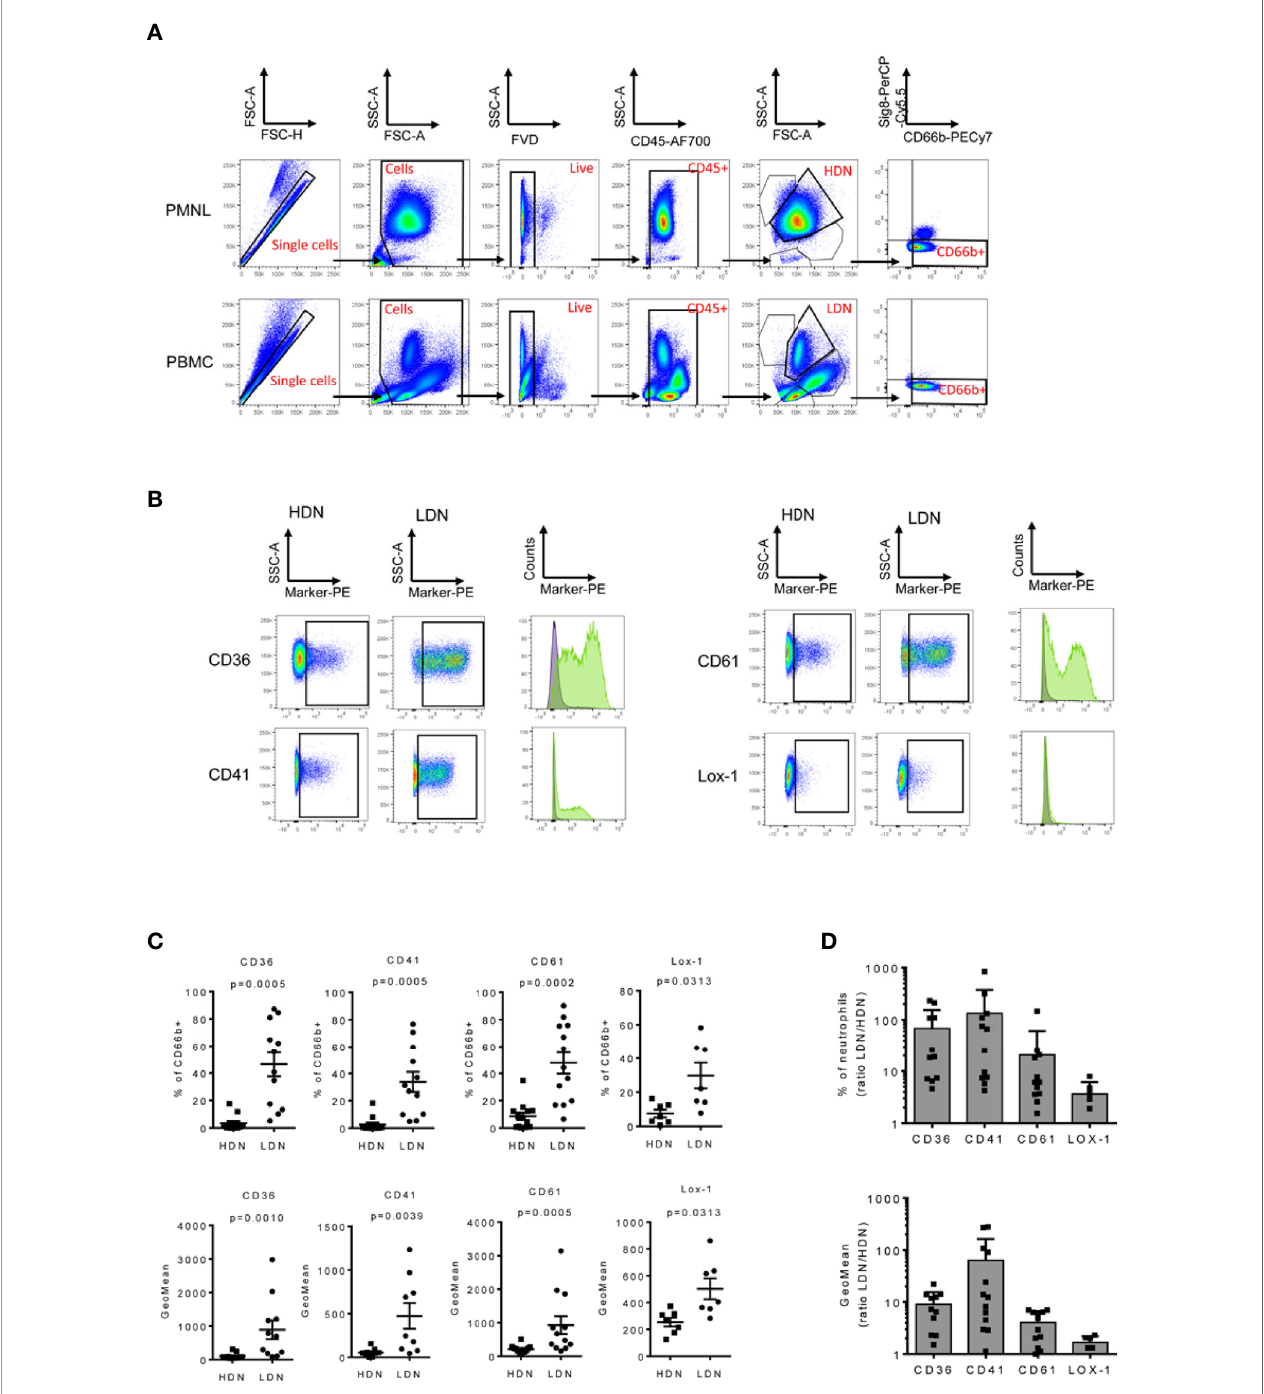
FIGURE 4 | LDNs overexpress CD36, CD41, CD61 and Lox1. PMBCs and PMNLs were isolated from 13 NSCLC patients and stained to validate the surface marker expression by fl ow cytometry. (A) Representative fl ow cytometry dot plots demonstrating the gating strategy. Initial gate is to eliminate doublets from the analysis followed by gating on total cells, live (FVD) and CD45 + cells. HDNs and LDNs were gated base on its forward and side scatter properties. Neutrophils were identi fi ed as CD66b + Siglec8 - cells (B) Representative dot plots and histograms showing an increased expression of CD36 + , CD41 + , CD61 + and Lox1 + in the LDN fraction of cancer patients. (C) Quantitative analysis of the marker expression as % of CD66b + cells and GeoMean in the HDN and LDN subsets in NSCLC patients. (D) The LDN/HDN ratio of the different markers was also analyzed. Statistical differences were assessed by using paired t-tests or Wilcoxon matched-pairs and data are expressed as the mean ±